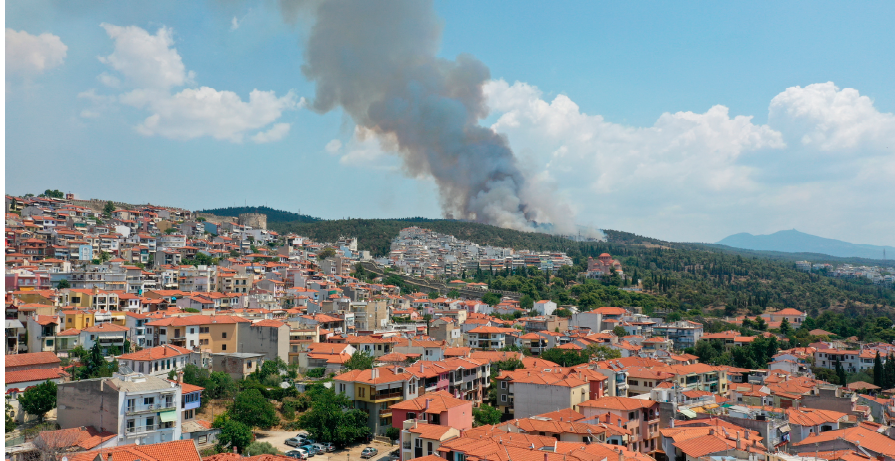
Figure 10. Fire event captured in Thessaloniki on 13 July 2021.